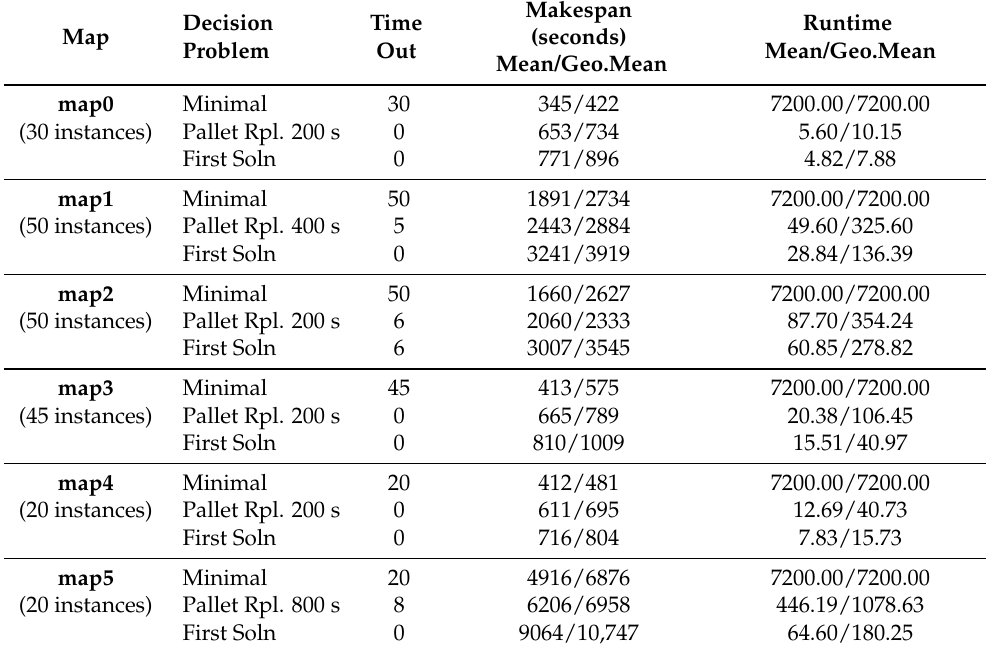
Table 9. Comparison of makespan by map and decision problem for the high performance